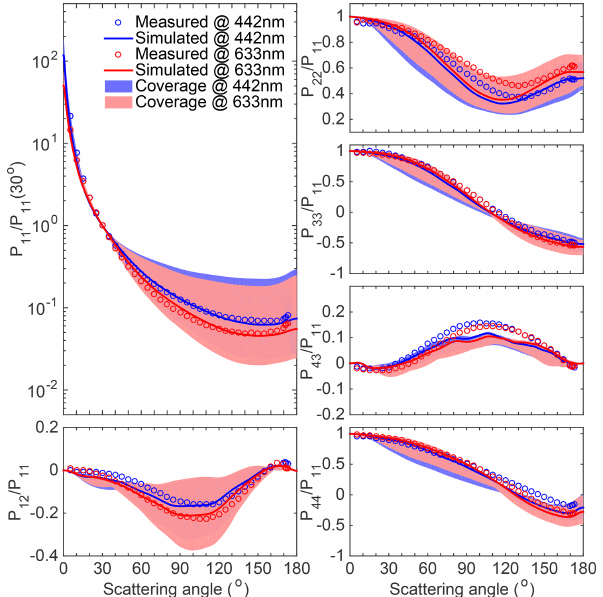
Figure 7. Similar to Fig. 6, but for the loess sample. The optimal RI is 2 . 2 + 10 − 2 i at the wavelength of 442nm and 1 . 6 + 10 − 4 i at the wavelength of